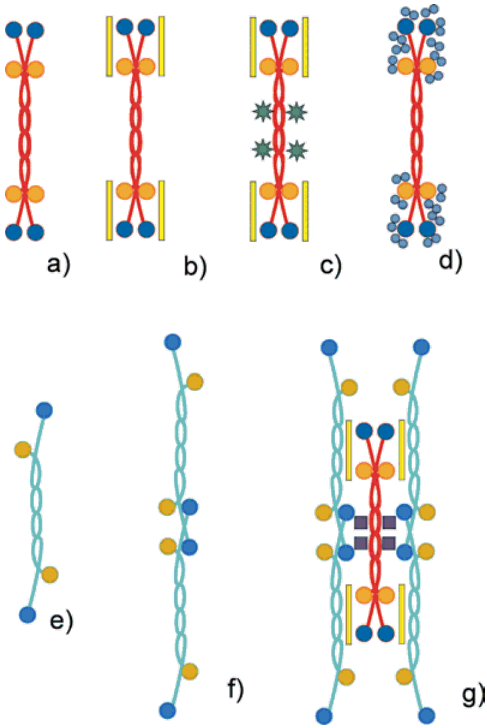
FIGURE 6. Summary of the possible collagen VI structural interactions that form the building blocks that make networks. (a) Collagen VI tetramer. (b) As in (a) but with extra material binding to the tetramer outer segments (yellow bars). (c) As in (b) but with globular proteins that may account for the formation of extra bands of protein density. (d) As in (a) but with TIMP3 associating with the tetramer outer segments. It may well be that TIMP3 is the extra material represented in (b). (e) Collagen VI dimers. (f) Linear interaction of two dimers through the dimer outer segments to form a chain. (g) Lateral associations of chains of dimers with tetramers. Extra material associating with the tetramer outer segments may explain the greater electron density seen in correspondence of the main pairs of